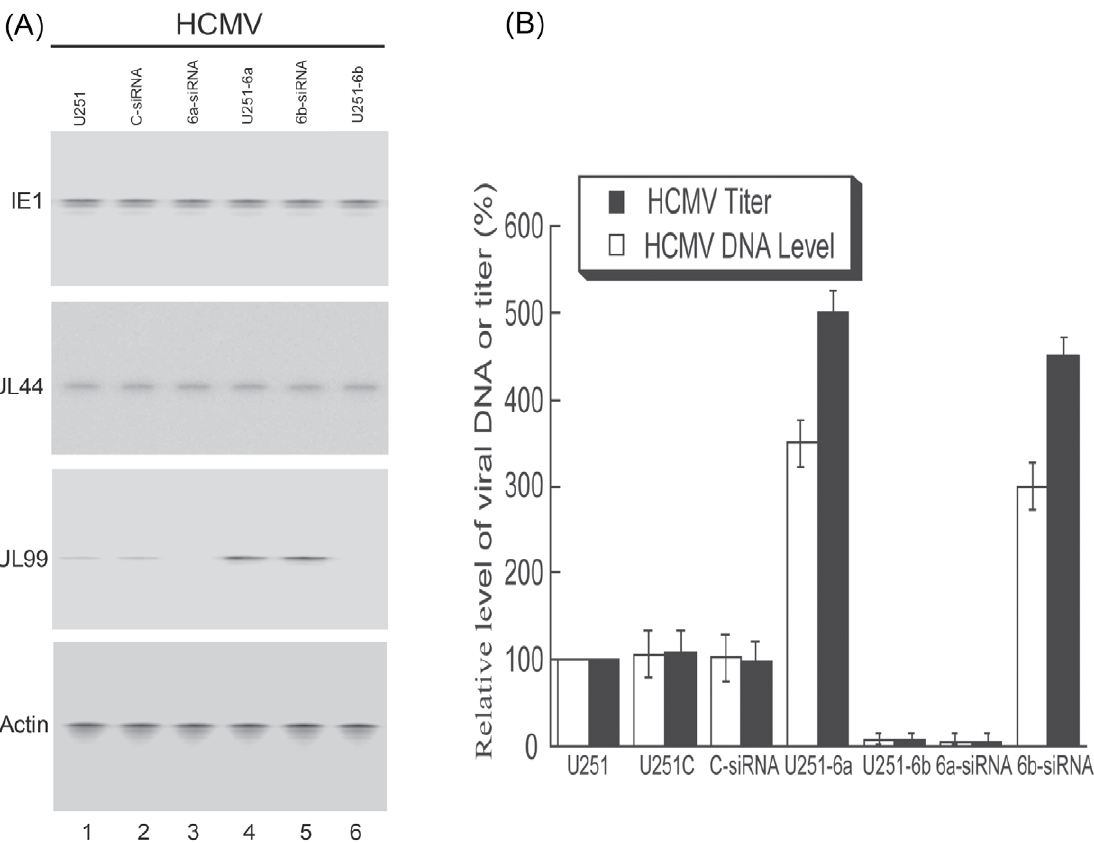
Figure 8. Effect of up- and down-regulation of the expression of DNAJB6 on HCMV gene expression, and viral genomic synthesis and production. (A) Western blot analysis of the levels of HCMV IE1, UL44, and UL99 in the parental U251 cells (U251) (lane 1), cells overexpressing DNAJB6a (U251-6a) (lane 4) and b (U251-6b) (lane 6), or U251 cells that were transfected with either anti-DNAJB6a (6a-siRNA) (lane 3) and DNAJB6b siRNA (6b-siRNA) (lane 5) or control siRNA (C-siRNA) (lane 2). The expression of cellular actin was used as the internal control. At 48 hours posttransfection, cells were infected with HCMV (MOI=1). Protein samples were prepared at 48–72 hours postinfection. (B) To assay the level of intracellular viral DNA, cells were harvested at 72 hours postinfection. To assay the level of viral production, total infection cultures were collected at 5 days postinfection and viral titers were determined. The values of the relative levels of HCMV DNA and titers, which are the means from triplicate experiments, represent the ratios of the levels of viral DNA or titers in different cells to those in the parental U251 cells (U251), respectively. The analyses were repeated three times and the standard deviation is indicated by the error bar.